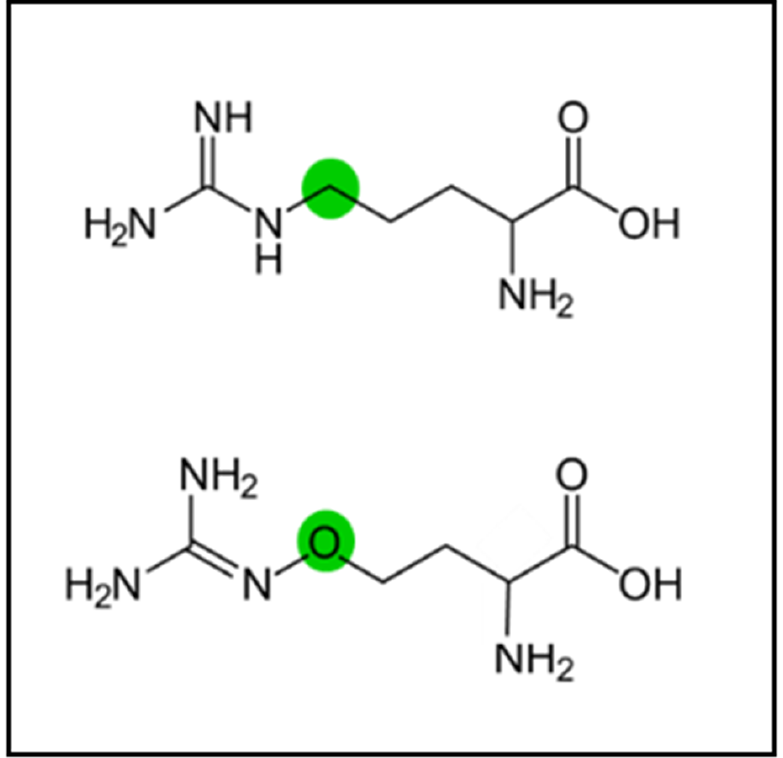
Figure 1. Chemical structures of arginine ( up ) and canavanine ( down ); green dots highlight the differential structural features.